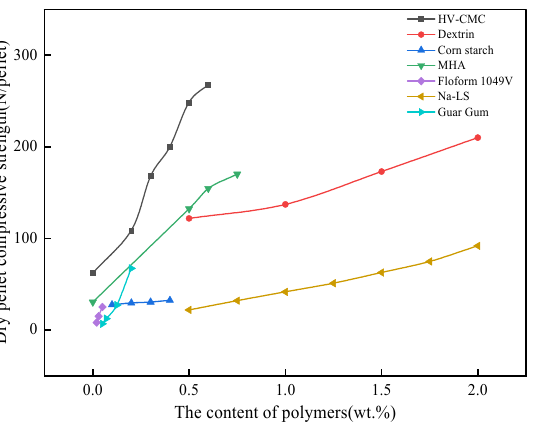
Figure 5. The effect of organic polymers on the dry pellet compressive strength [53–56,58–60]. As can be seen from the figures, in the range from 0~2wt.% addition of organic polymers, the approximate order of the influence on the green and dry pellet strength is Floform 1049 V > Guar Gum > HV-CMC > LV-CMC > MHA > Na-LS > Corn starch > Dextrin. Floform 1049 V, Guar Gum, and HV-CMC have large molecular weight and high solution viscosity, which can easily form strong cohesion inside the pellet, while their molecular structures contain a large number of active functional groups such as